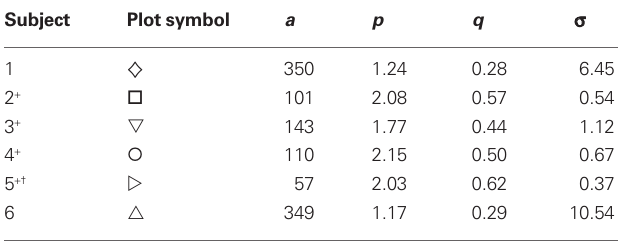
Table 1 | Fit parameters for threshold versus contrast functions for the six subjects who responded reliably to the low-contrast stimuli during MR scanning